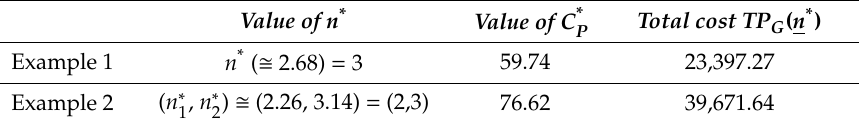
Table 3. Optimal solutions of the numerical